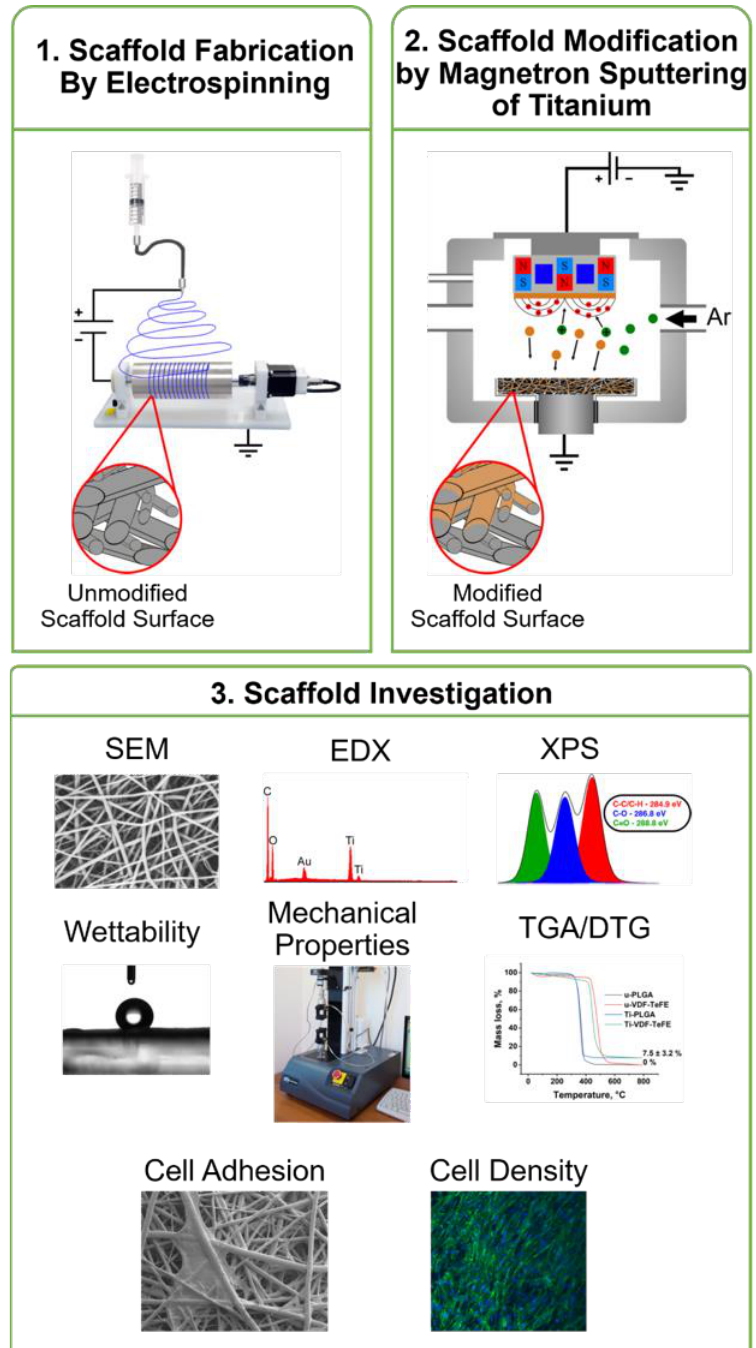
Figure 1. Experimental scheme of ( 1 ) the fabrication of the poly(lactide-co-glycolide) (PLGA) and vinylidene fluoride-tetrafluoroethylene (VDF-TeFE) copolymer scaffolds via electrospinning; ( 2 ) the subsequent surface modification by pulsed DC magnetron sputtering of titanium; and ( 3 ) the inves- tigation of the mechanical properties of all scaffold samples and the investigation of the adhesion of gingival fibroblasts to the scaffold sample